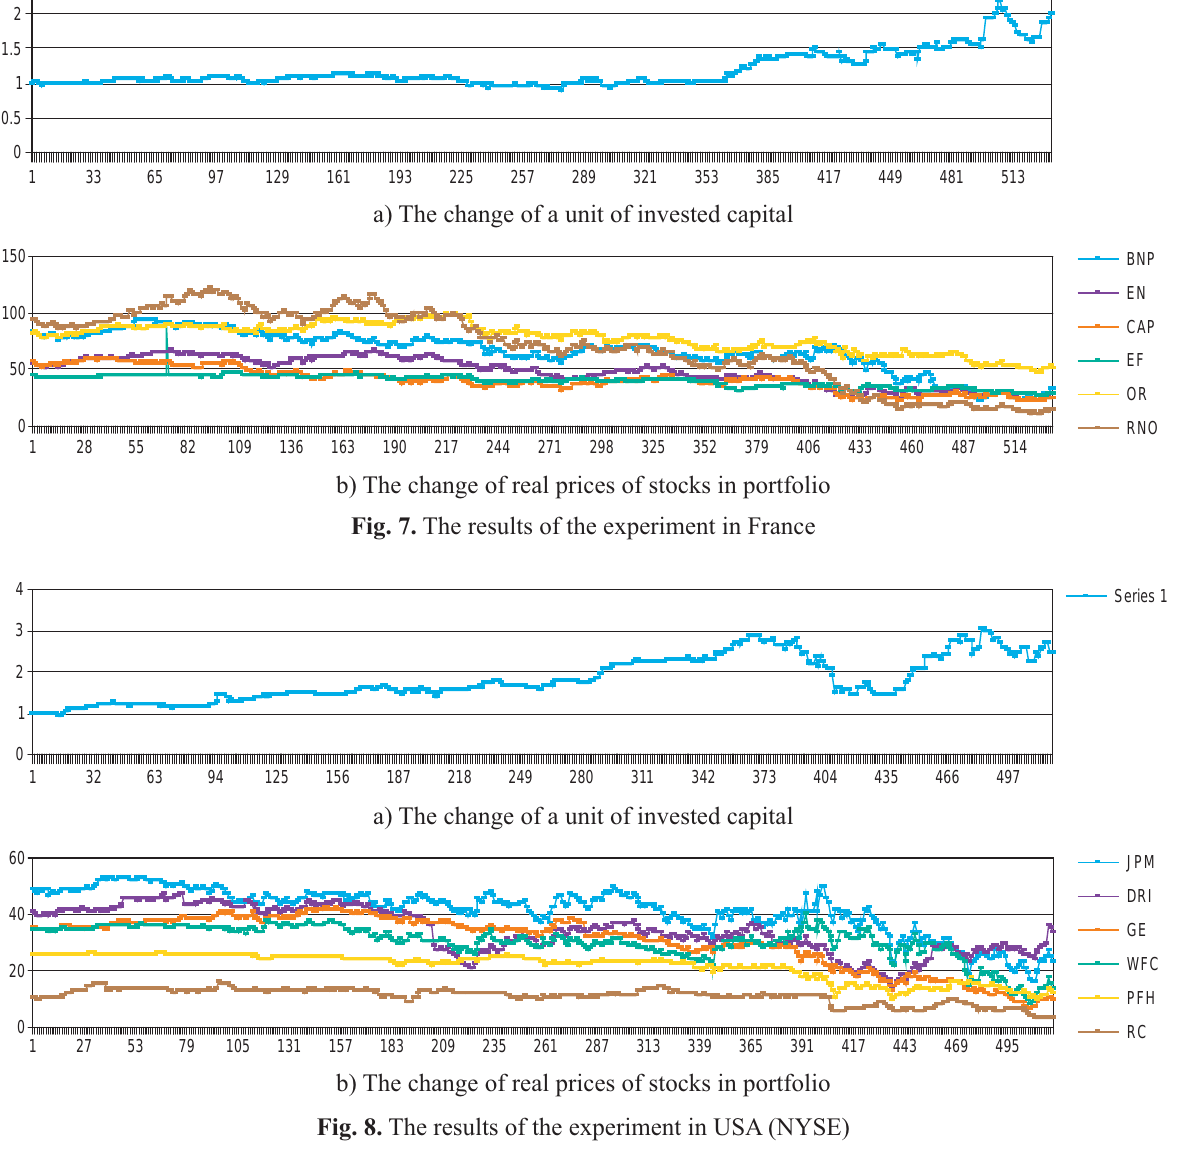
Fig. 8. The results of the experiment in USA